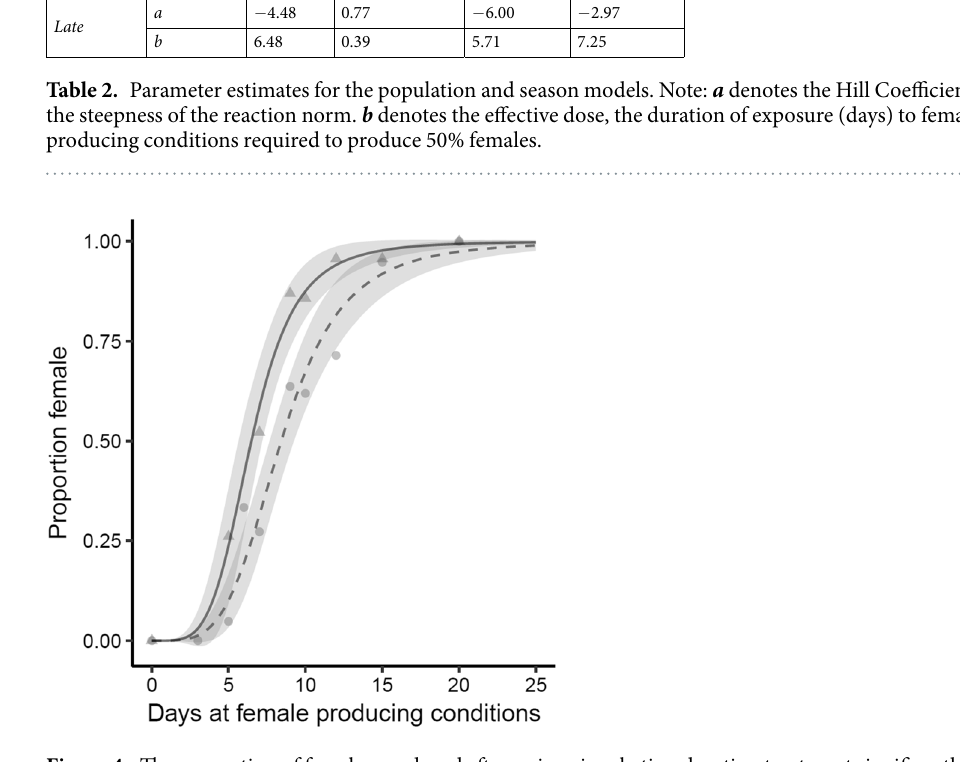
Figure 4. The proportion of females produced after a given incubation duration treatment significantly differed between early and late season individuals in Illinois. Late season clutches required less exposure to female temperatures to achieve a balanced sex ratio than early season clutches. The season specific sex ratio reaction norms are depicted by the curves (early season: dashed line, late season: solid line). Circles are early season proportions by treatment, and triangles are late season proportions by treatment. The ribbons correspond to 95% confidence